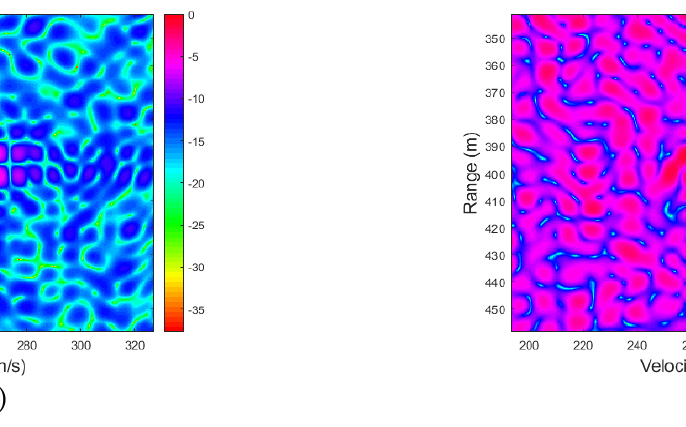
Figure 7. Normalized range-velocity image of three clustered targets with R = [400 m, 400 m, and 394 m] and V = [260 m/s, 253 m/s, and 260 m/s], level in dB ( a ) Using the SDFnT-based method ( b ) Using the 2D-FFT method.